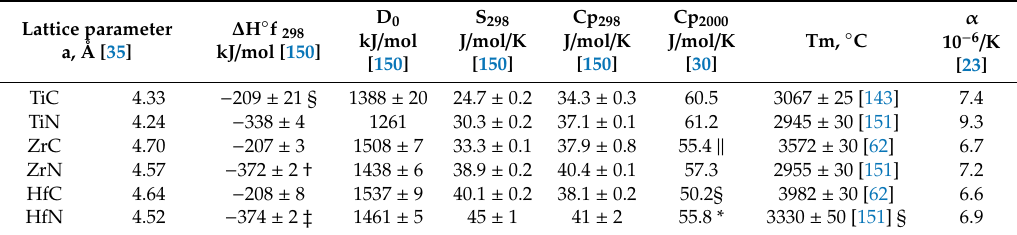
Table 2. Selected thermodynamic properties for rocksalt carbides and nitrides of Ti, Zr, and Hf: lattice parameters, enthalpies of formation, bond dissociation energies, standard entropies, heat capacities, melting temperatures, and thermal expansion coe ffi